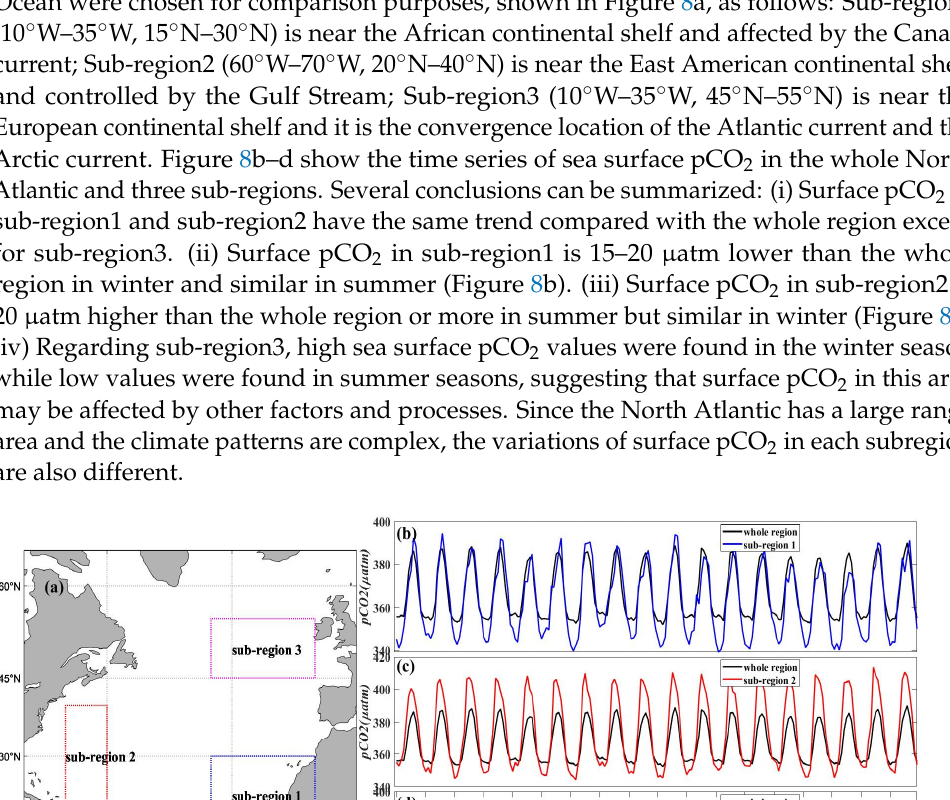
Figure 8. ( a ) Location of each sub-region. ( b – d ) Monthly surface pCO 2 time series in the whole North Atlantic and in the three sub-regions from January 2003 to December 2020. Empirical orthogonal function (EOF) analysis was employed to detect the spatial and temporal variation of the annual mean sea surface pCO 2 in the North Atlantic Ocean dur- ing the period 2003–2020. First of all, Figure 9a,b show the spatial and temporal distribu- tion of the first principal component (EOF1) respectively, and variance contribution rate of EOF1 reaches 0.86. The figures show that there is an opposite trend between southwest- ern of the North Atlantic and other regions and that is the main spatial distribution in the whole region. In terms of timescale, 2013–2018 has the opposite trend with other years. Besides that, Figure 9c,d show that the spatial and temporal distribution of EOF2, respec- tively, and variance contribution rate has 0.10 in this component. Figure 9d suggests that 2019 and 2020 have strong converse trends compared with other years. In addition, dif- ferent sub-regions have opposite tendencies. For example, sub-region1 and sub-region3 may have diverse variations between 2003 and 2020. Through the EOF analysis, the dis- tribution and variation of each sub-region can be observed separately from the perspec- tive of time and space. Figure 9. The results of EOF analysis of surface pCO 2 in the North Atlantic from 2003 to 2020. ( a ) The spatial distribution of the first principal component. ( b ) The temporal distribution of the first principal component. ( c ) The spatial distribution of the second principal component. ( d ) The tem- poral distribution of the second principal component.